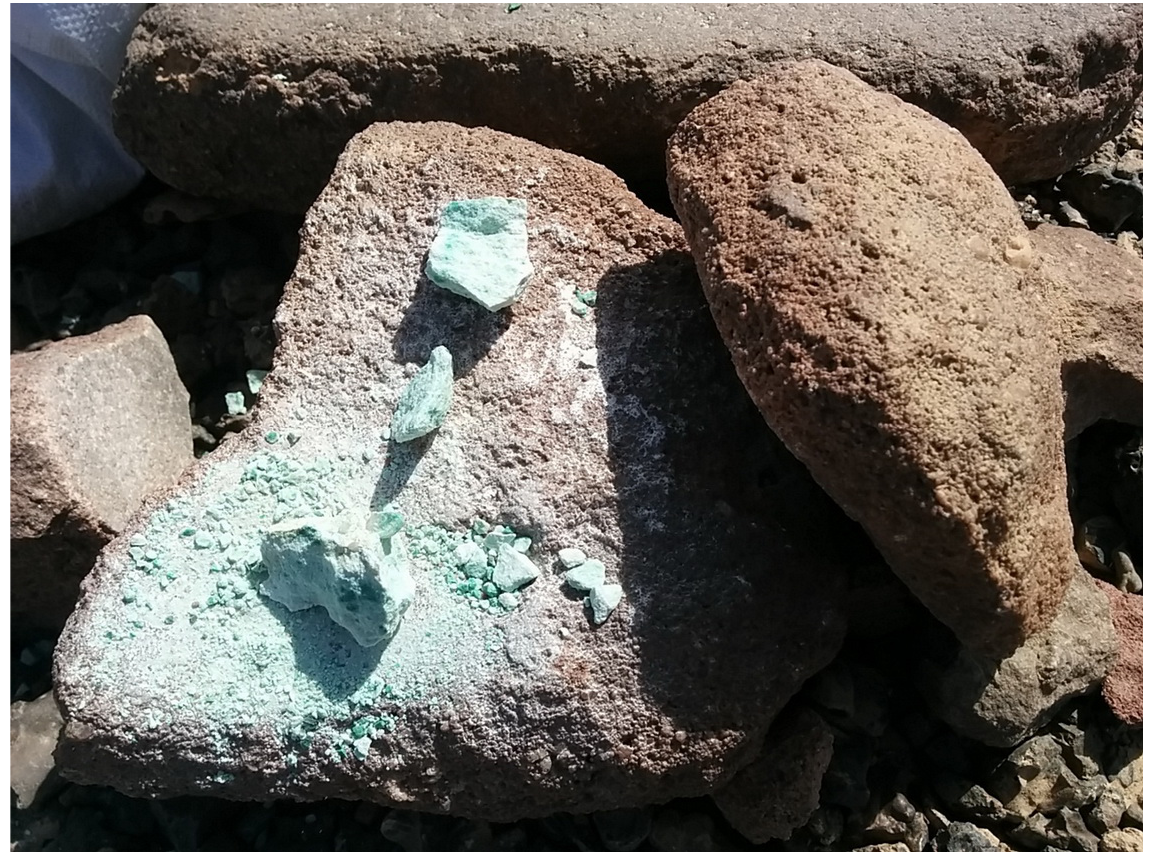
Figures 24. Modern experiments using ground stone tools which were collected from Site 34 - grinding stones used to grind the local copper